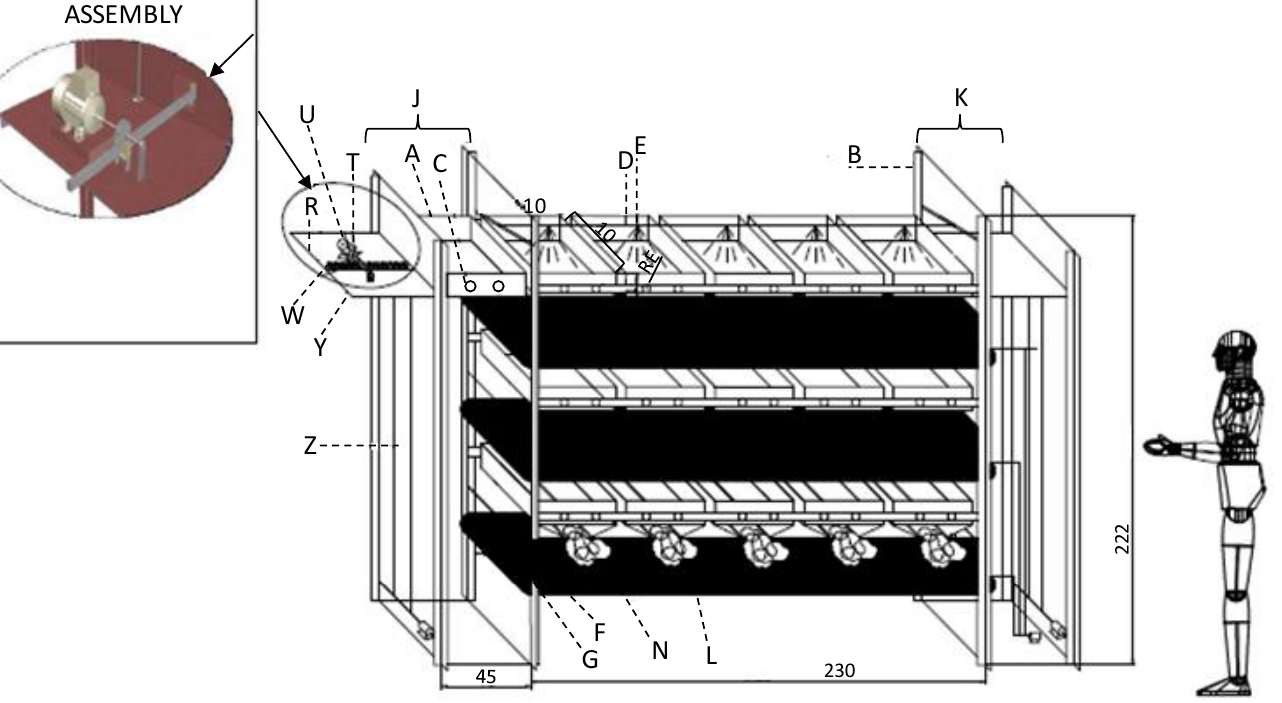
Figure 1. Schematic of the high efficiency vertically stacked vermicomposting system for treating organic waste (HEVSTOW); the human figure has been put to give an indication of the size.